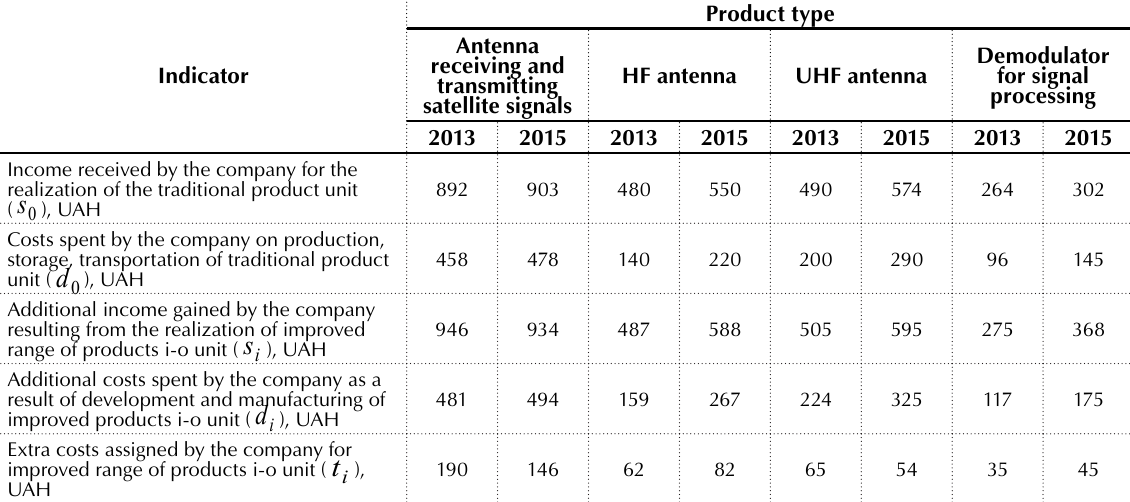
Table 1. The data on the range of products manufactured at the enterprise